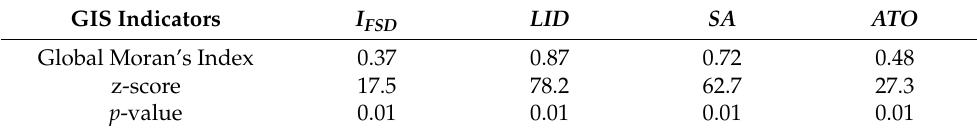
Table 4. Evaluation of the global Moran’s I statistic for the different GIS indicators. GIS Indicators I FSD LID SA